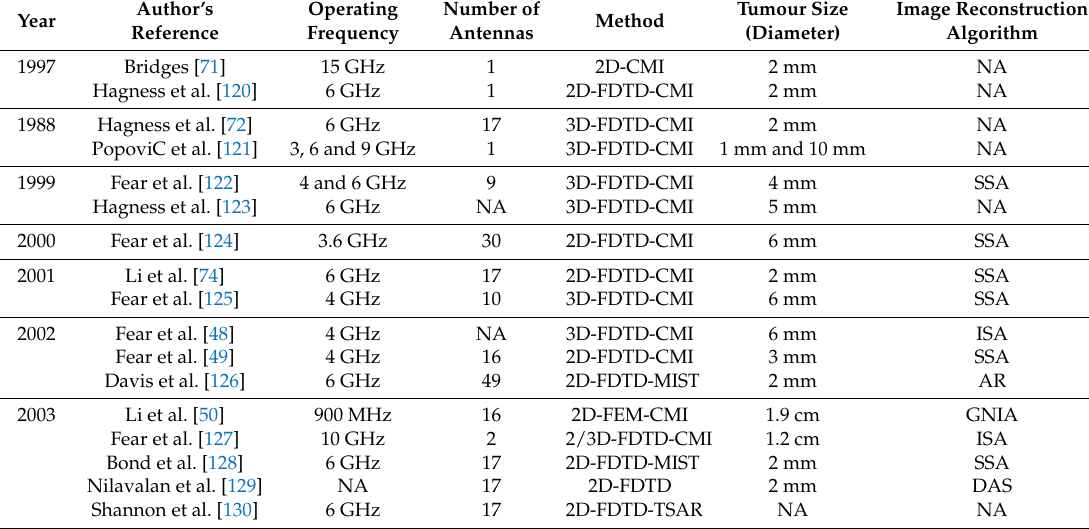
Table A1. Chronological summary of MI radar-based methods and